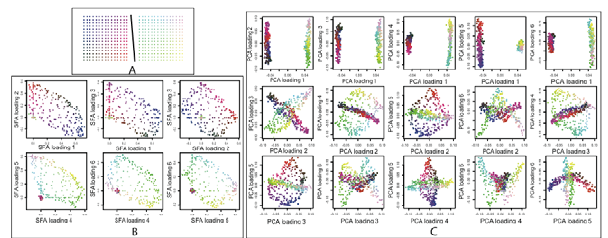
Figure 7. Results on simulated genotype data from a two independent 2-D habitats. In Panel A, each dot represents a population colored according to habitat and location. Colors in Panels B and C indicate locations in Panel A. Panel B shows how SFA captures the structure with a six factor model. Loadings on the first three factors (first row of Panel B) correspond to location in the first habitat; individuals in the second habitat have essentially zero loading on these factors. Similarly, loadings on the other three factors (second row of Panel B) correspond to location in the second habitat. Panel C shows estimated loadings from PCA for the same data. Each plot shows one loading plotted against another. Although the PCA results clearly reflect the underlying structure one might struggle to infer the structure from visual inspection of these plots if the colors were unknown.